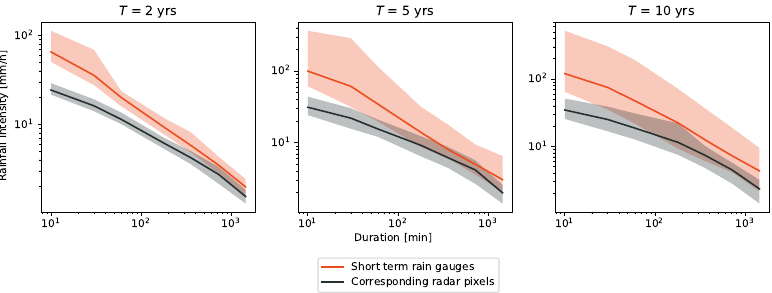
Figure 5. IDF-curves for all of the short-term rain gauges (orange) and their corresponding radar pixels (black). The solid line indicates median values and the shaded area depicts the total ensemble spread between gauges. The curves represent return levels of 2, 5, and 10 years.